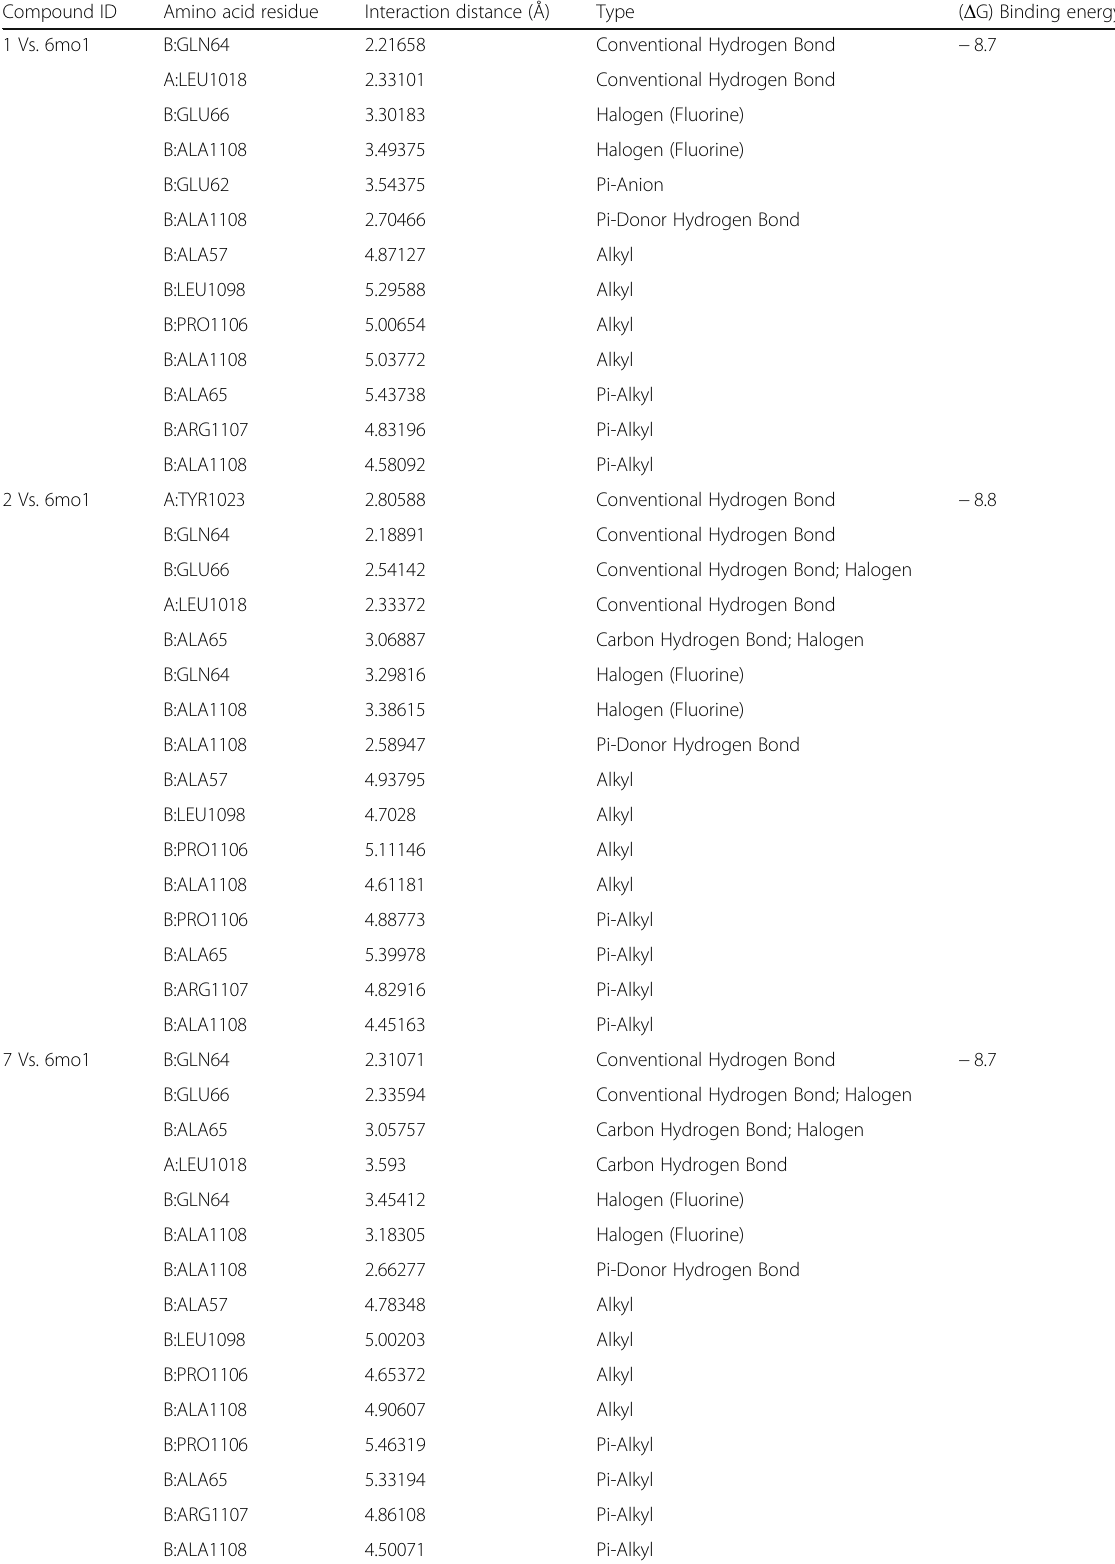
Table 10 Interactions between compounds with a therapeutic target (DNV-2-NS-2B/NS-3 PDB 6M01) Compound